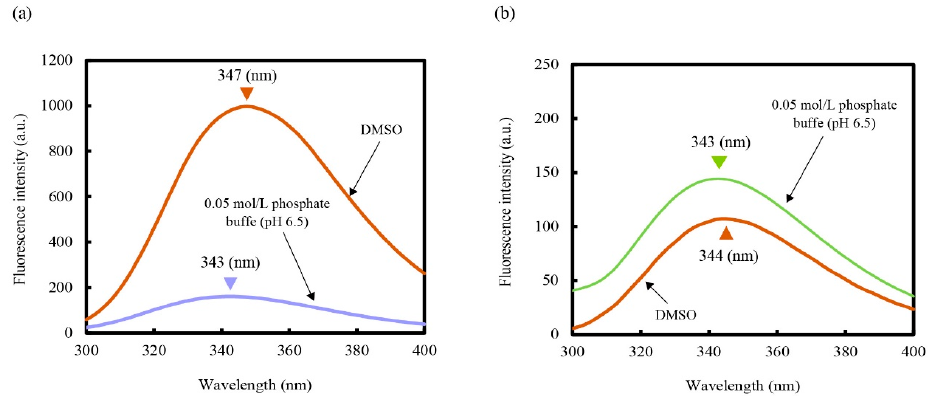
Figure 9. Fluorescence emission spectra of lysozyme ( a ) and CHLysozyme ( b ) in 0.05 mol/L phosphate buffer (pH 6.5) and DMSO at 25 °C. Lysozyme and CHLysozyme concentration: 0.2 mg/mL. Excitation wavelength: 280 nm. Gain value of fluorescence spectrometer: medium.